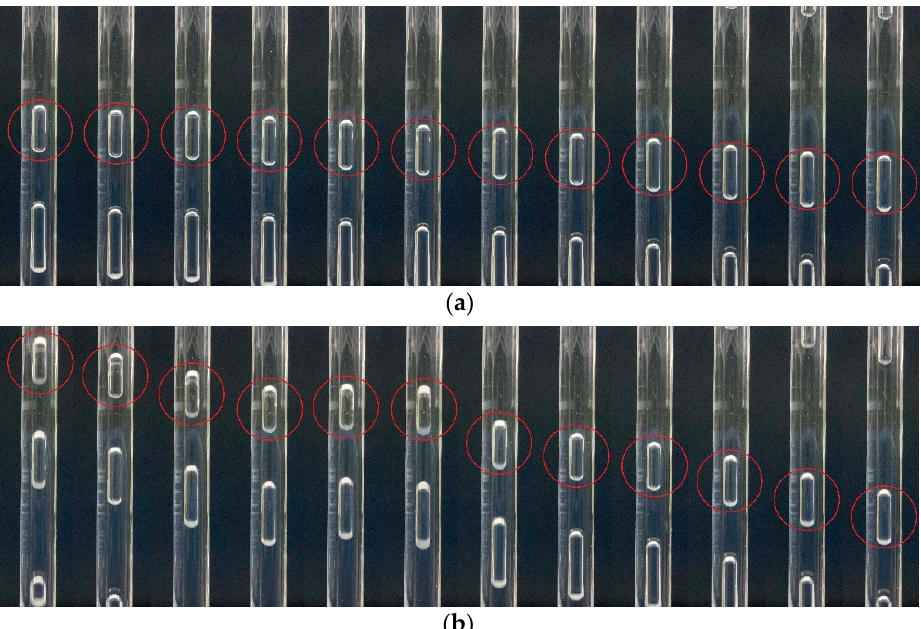
Figure 10. Dynamic photos (shooting time interval: 0.1 s) of bubble generation and rupture in the evaporating section of the PHP under ( a ) vibration-free condition, and ( b ) vibration condition.